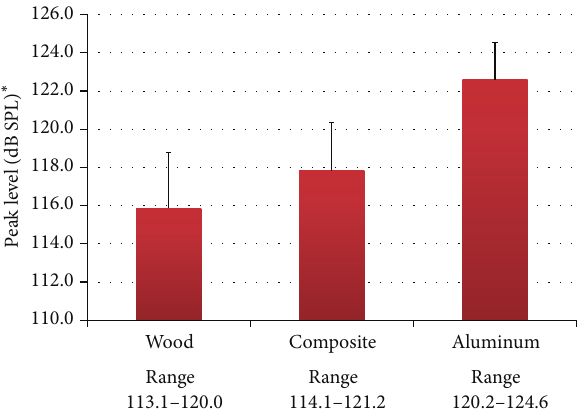
Figure 1: Mean peak levels with standard deviations are shown for each of the three softball bat materials. The range of raw peak levels is also shown. ∗ Peak levels are C-weighted measures.